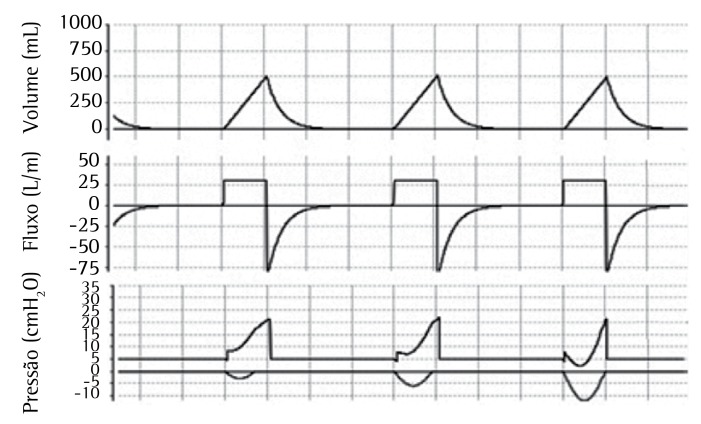
Assincronia de fluxo. Na modalidade volumecontrolada, o fluxo foi
ajustado aquém da demanda do paciente, que mantém esforço muscular
durante toda a inspiração, a qual passa a apresentar uma concavidade
voltada para cima. Essa assincronia está representada com intensidade
progressiva do primeiro para o terceiro ciclo na figura. As deflexões
negativas nas curvas pressão versus tempo representam os esforços do
paciente (pressão muscular), sendo visualizadas somente quando se
monitoriza a pressão esofágica. Figuras obtidas pelo Xlung.net, simulador
virtual de ventilação mecânica. Disponi´vel em: http//:www.
xlung.net.